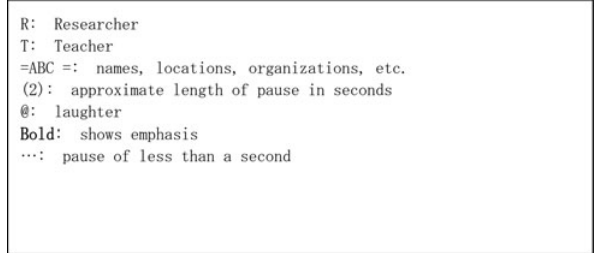
Fig. 1. Transcription